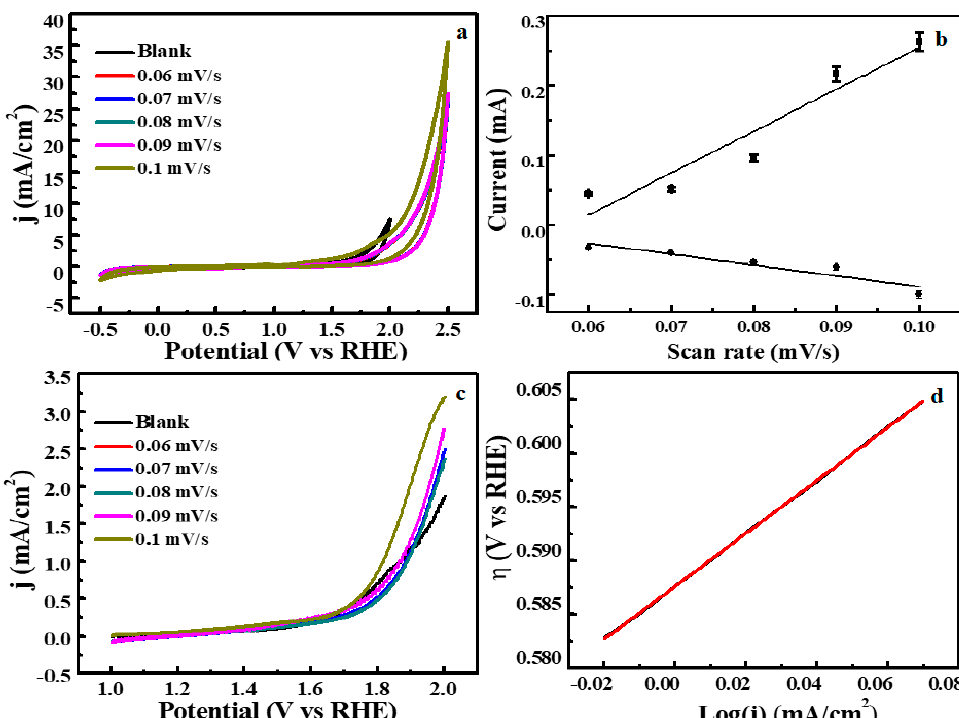
Figure 4. ( a ) Cyclic voltammogram and ( b ) calibration curve; ( c ) LSV curves and ( d ) the correspond- ing Tafel plots of nitrogen doped carbon at different scan rates in 1 M KOH.